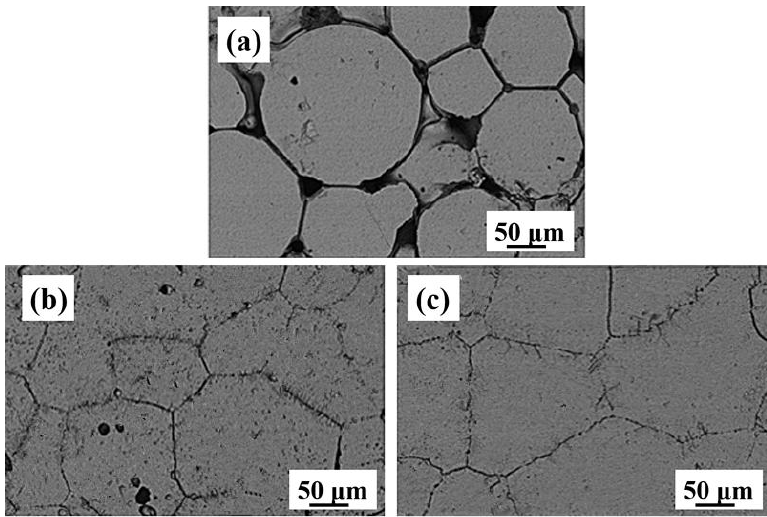
Figure 6. SEM images (800×) of Ti-28Nb-35.4Zr alloy prepared with different sintering temperatures and powders: ( a ) 1500 °C/AP; ( b ) 1500 °C/BMP and ( c ) 1550 °C/BMP.